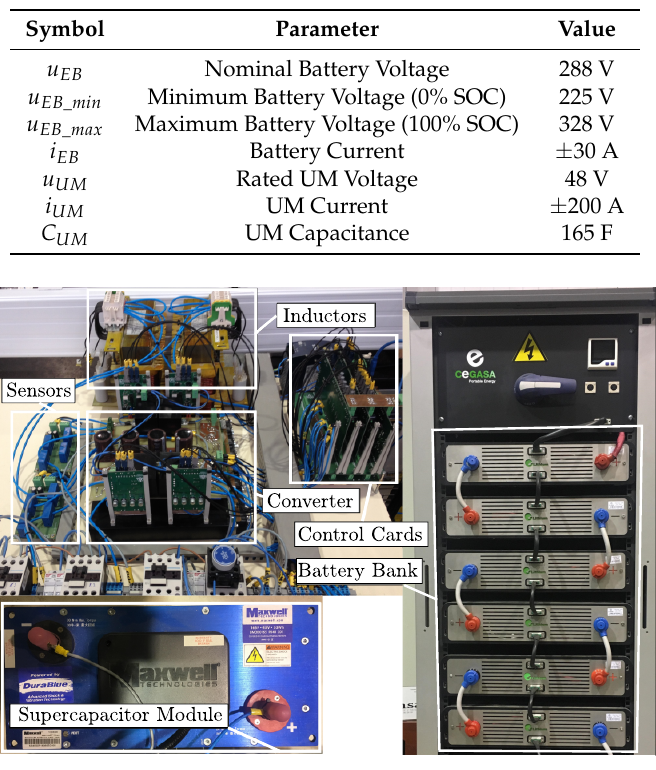
Figure 3. Experimental setup that can be configured as Parallel Connection (PC), Full Bridge Converter (FBC), Series Connection (SC) or Series-Parallel Connection